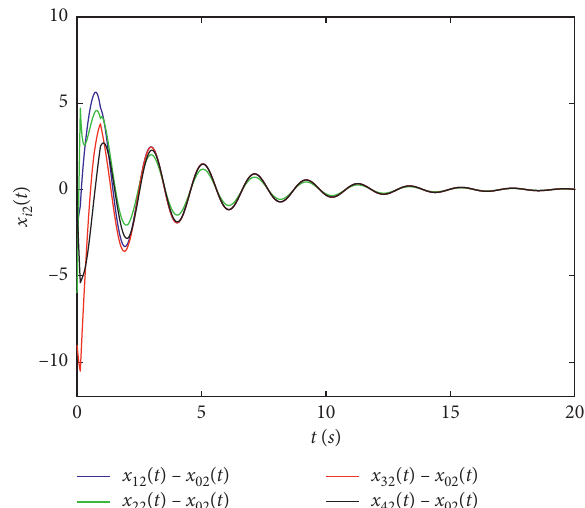
Figure 4: The 2st state error trajectory of each agent under protocol (10).